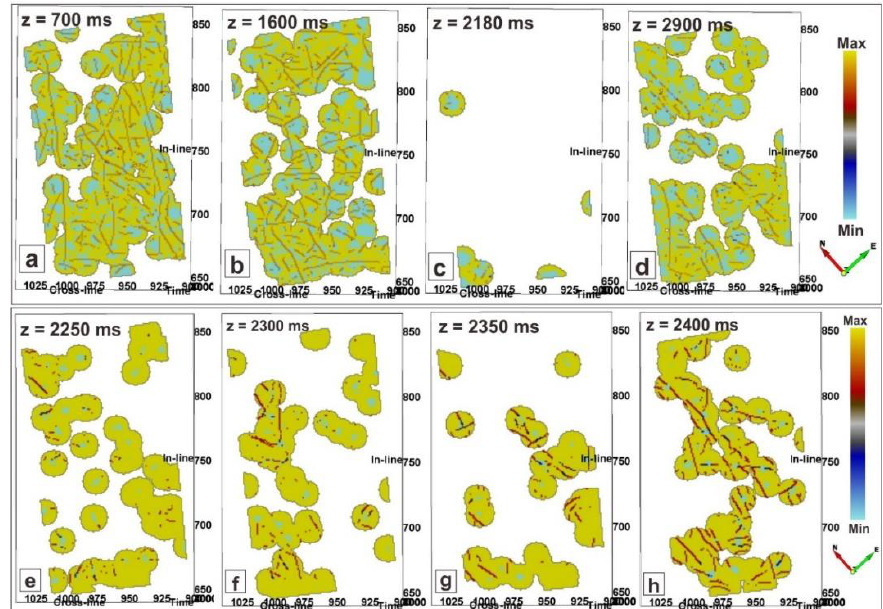
Figure 12. The results of the neural networks highlighting the fracture network: ( a ) ANN–UVQ cube and ( b ) ANN–UVQ section. Red rectangles show the fractured regions.